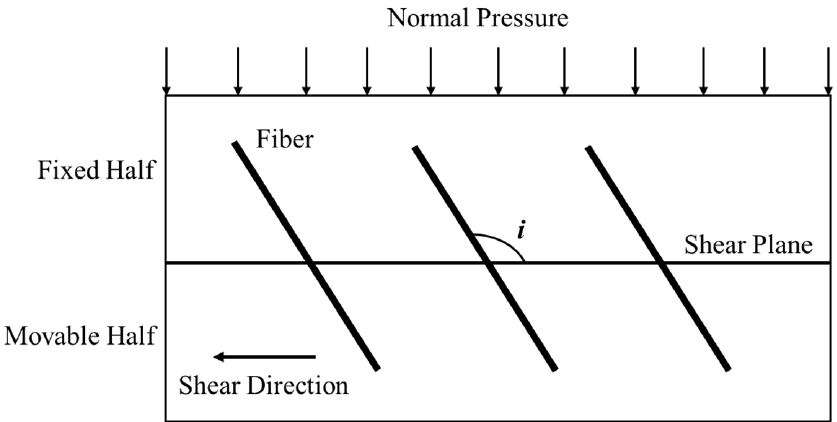
Figure 1. Schematic diagram of direct shear test and orientation angle.